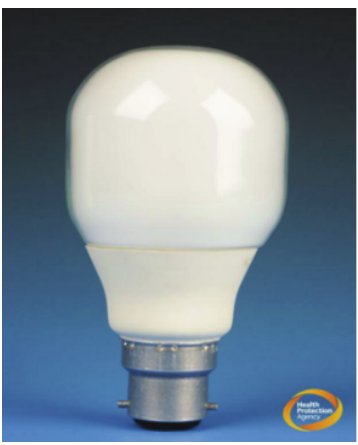
Figure 2: Shield envelop